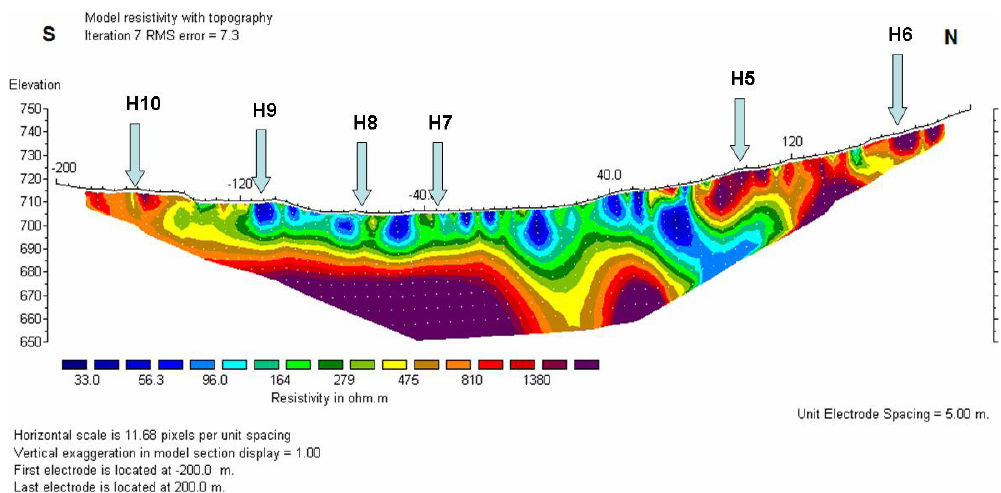
Fig. 6. ERI pseudosection of Transect 2 (Wenner